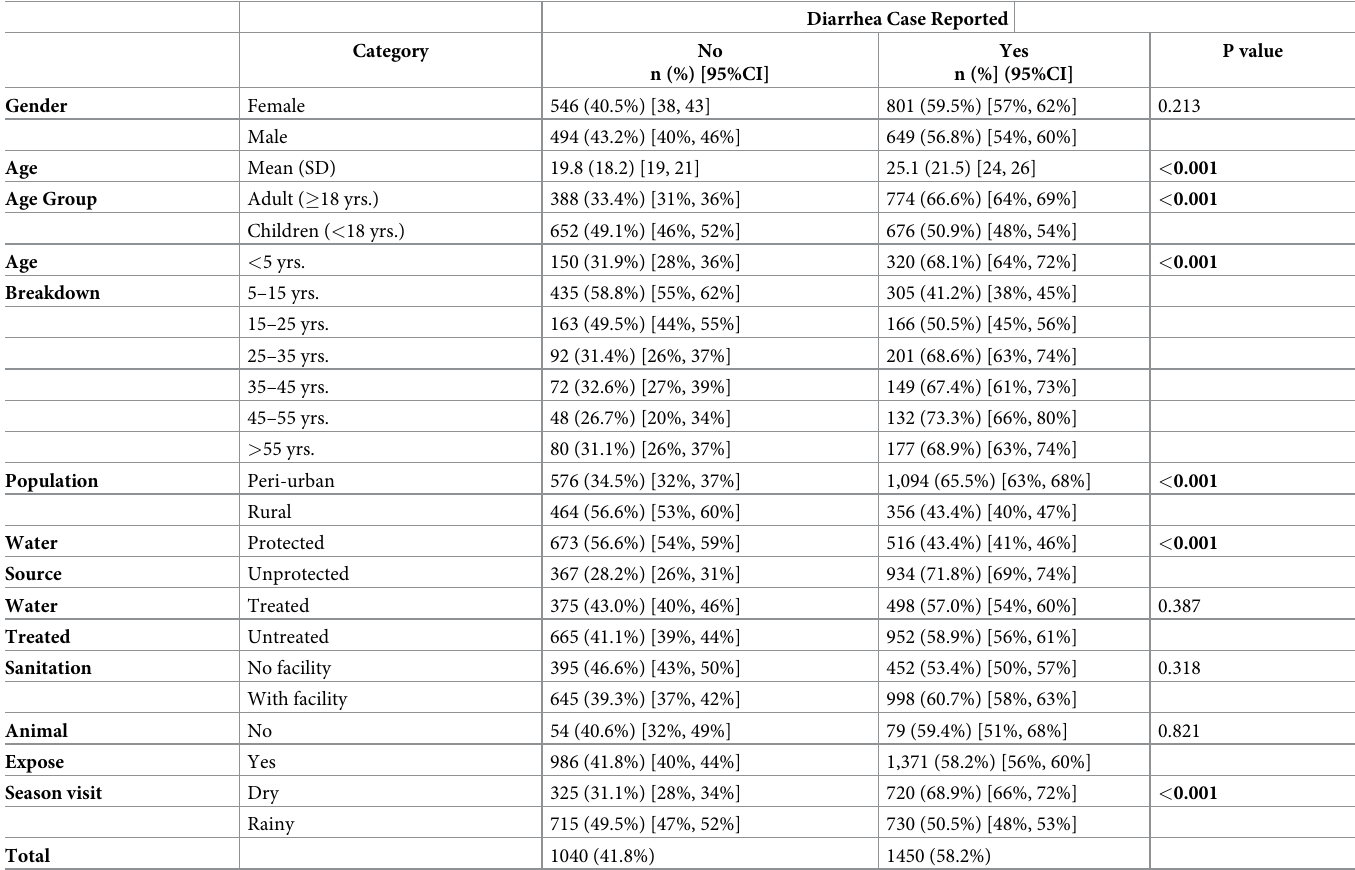
Table 2. Description of study patients reporting at least one case of